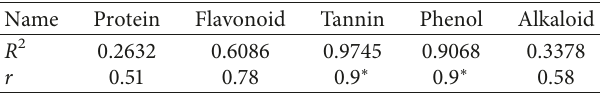
Figure 7: Thrombolytic activity of C. lanatum with IC Table 2: Results of regression correlation analysis of the total content in